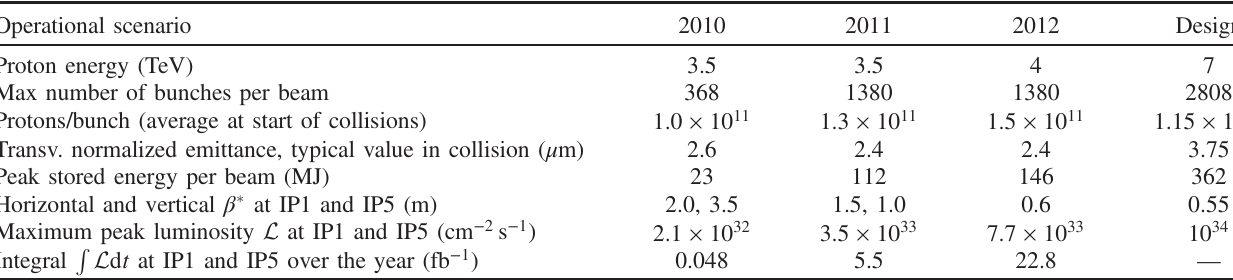
TABLE I. Proton beam parameters for the LHC in nominal collision conditions [2] as well as the parameters used in 2010, 2011, and 2012.